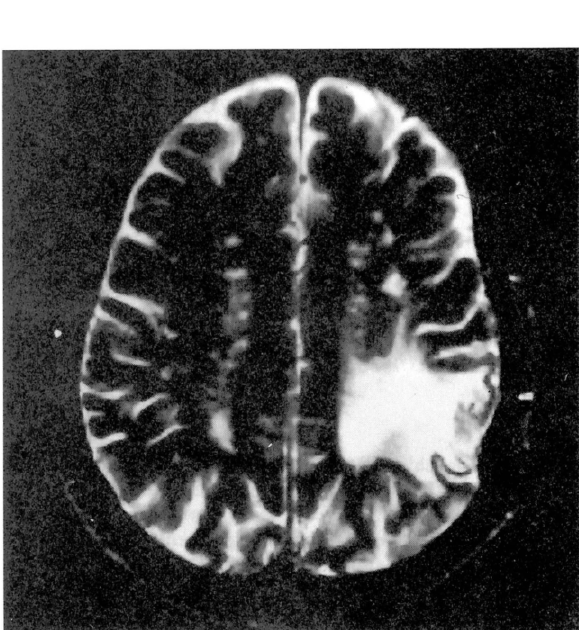
FIG. 1. A T2-weighted magnetic resonance image. Imaging was carried out in a 0.5 Tesla superconducting system (Shimazu. Kyoto) using the spin-echo method. TR/ TE = 2500/ 90 ms. A T2 high intensity lesion is visible in the right marginal gyrus and adjacent subcortex